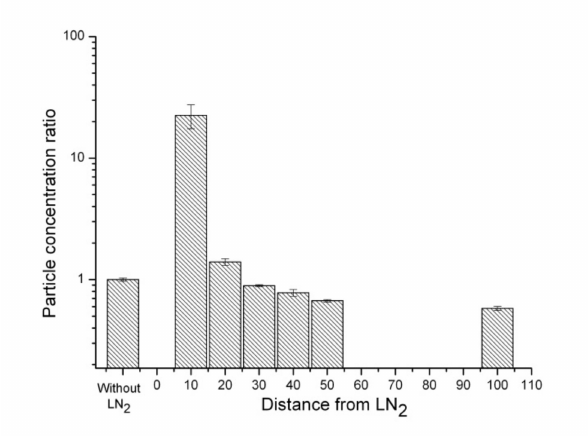
Figure 5. Concentration ratios of particles of size 1 µ m at distances of 10, 20, 30, 40, 50, and 100 cm from the LN 2